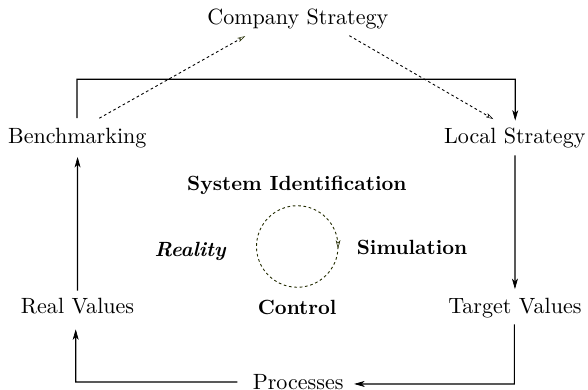
Figure 6. The interaction of system identification, control and simulation within process